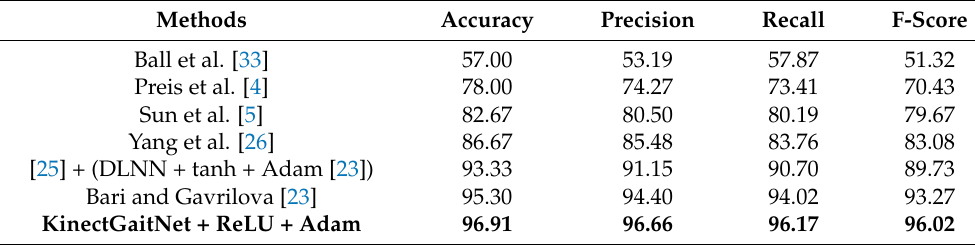
Table 10. Performance comparison of the proposed method with prior research on the UPCV dataset. The best performance is shown in